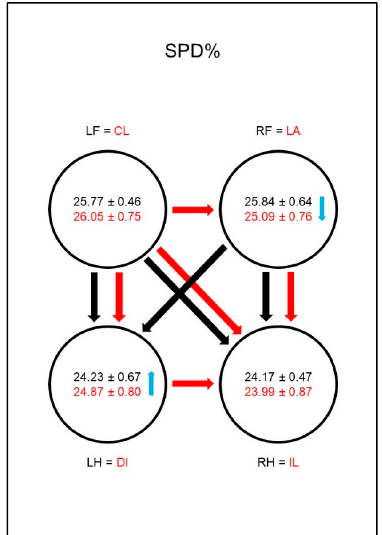
Figure 14. Stance phase duration as a percentage of total stance phase duration (SPD%) in study group 2 and control group. For detailed explanation and abbreviations refer to Figure 2.